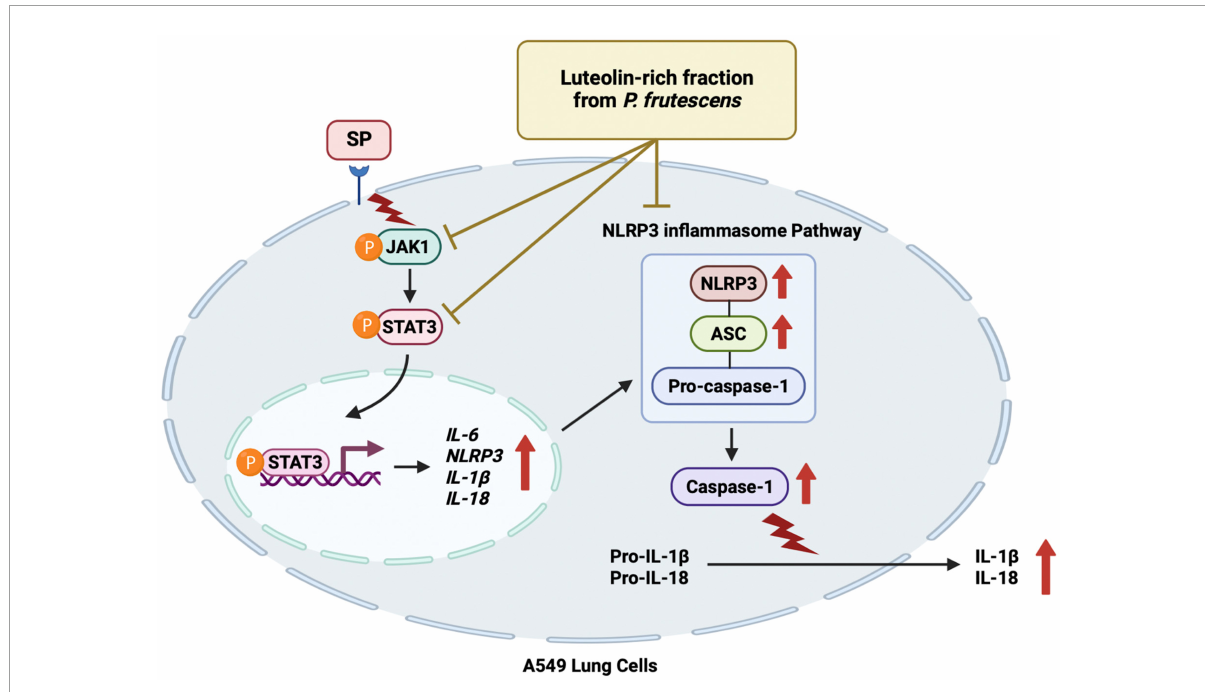
FIGURE6 Schematic conclude mechanism of luteolin-enriched fraction from P. frutescens seed meal (PFEA) attenuated Spike S1-induced NLRP3 inflammasome inflammation through the inactivation of the JAK1/STAT3 signaling pathway in A549